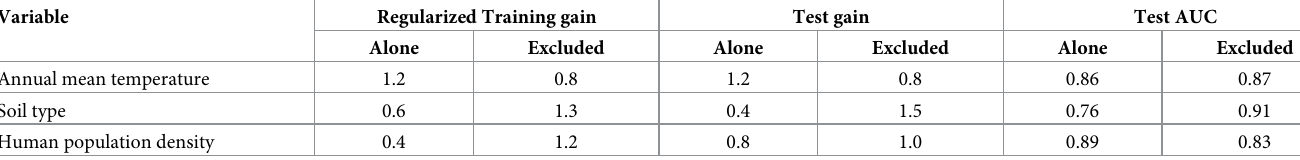
Table 3. Summary of the Jackknife analysis performed to determine importance per environmental